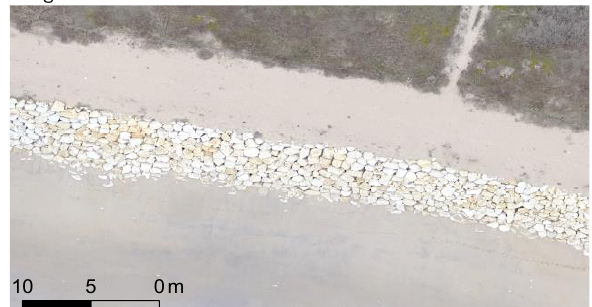
Figure 10: Example of a rock dike. Extraction from ortho- imagery, cell size 2 cm.